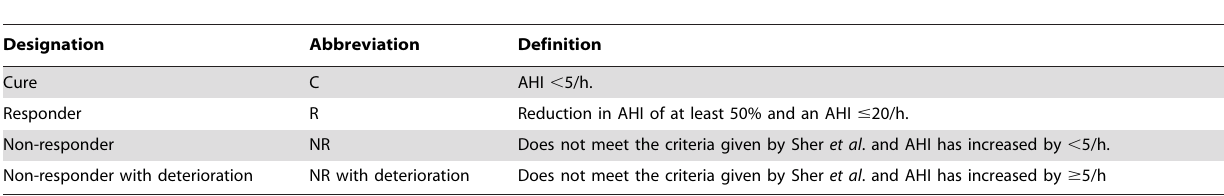
Table 1. Overview of classification criteria, showing designations, abbreviations and